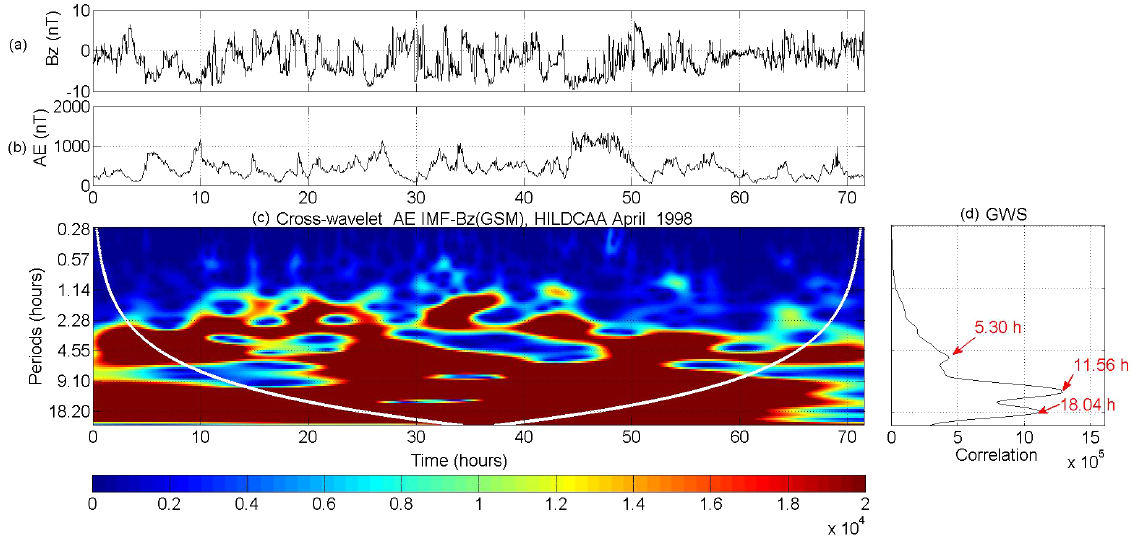
Figure 2. (a) Time series of the IMF B z component. (b) The AE index. (c) Cross-wavelet spectrum periodogram during the HILDCAA event from 17:11UT on 24 April to 16:46UT on 27 April 1998. (d) The global wavelet spectrum shows the main periods of